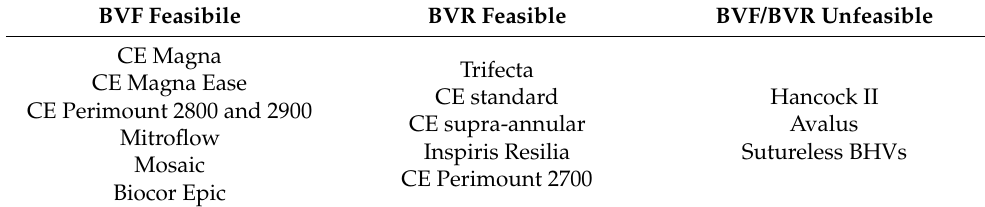
Table 2. Feasibility of BVF/BVR in surgical